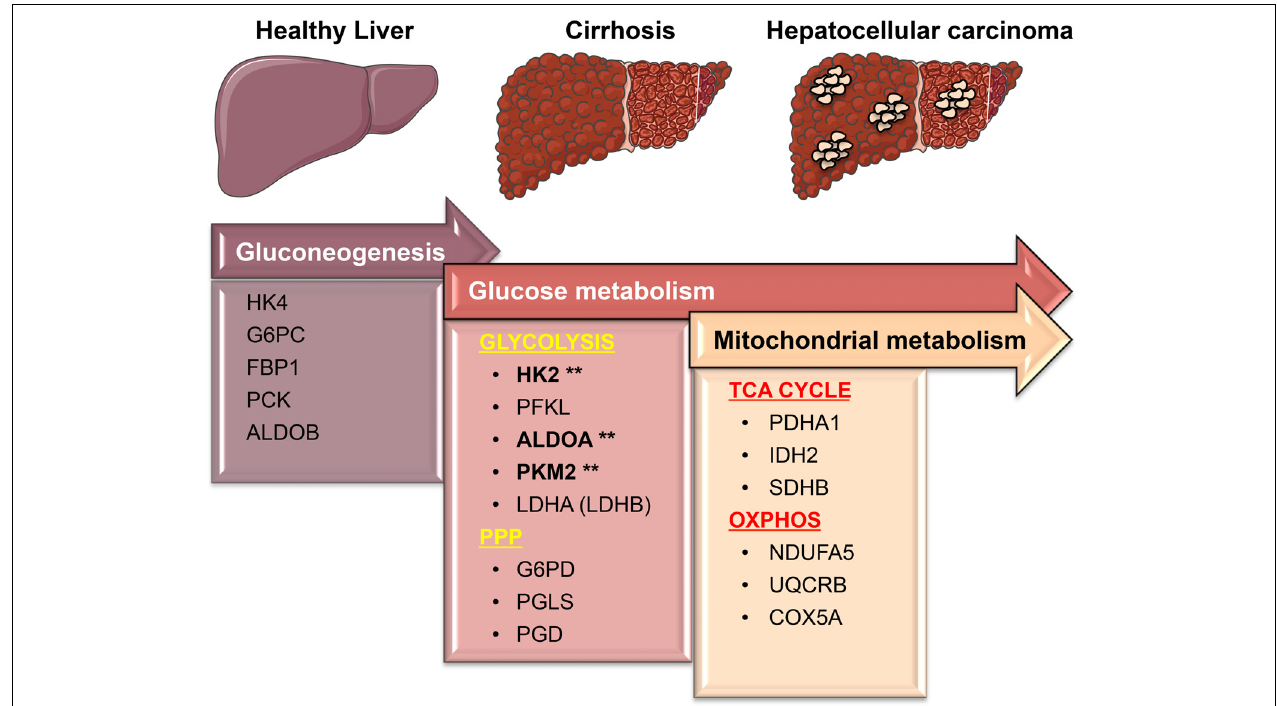
FIGURE 8 | A simplified model showing transcriptional changes in gene expression of metabolic enzymes that characterize the progression from a normal liver to cirrhosis, which culminates in HCC. One of the most pronounced transcriptional changes during the transition from normal to HCC is the suppression of HK4 and ALDOB followed by the induction of the high affinity HK2 and ALDOA. This allows glucose to enter in the cells and be converted into pyruvate. PKM2 and lactate dehydrogenase (LDHA/LDHB), the last two enzymes in the glycolytic pathway, are essentially needed to maintain the high glycolytic rate of liver carcinomas by fast removal of accumulating upstream intermediates to favor the entrance into other metabolic pathways such as the oxidative phase of PPP. Surprisingly, those metabolic changes mostly occur early on the premalignant stage (cirrhosis) during hepatocarcinogenesis. While in cirrhotic livers glycolysis provides both biosynthetic building blocks and anti-oxidant defenses needed for the survival (as opposed to apoptosis) of damaged cells, in livers with HCC glycolysis cooperates with OXPHOS and TCA cycle to sustain energy needed for fast proliferation and metastasis. Our analyses suggest that the expression of glycolytic enzymes such as HK2, ALDOA, and PKM2 (marked by asterisks) in precancerous, chronically inflamed livers may be considered as new predictive biomarkers to prevent the development of liver cancer. Figure was created modifying illustrations provided by Servier (http://smart.servier.com) under Creative Commons Attribution 3.0 Unported